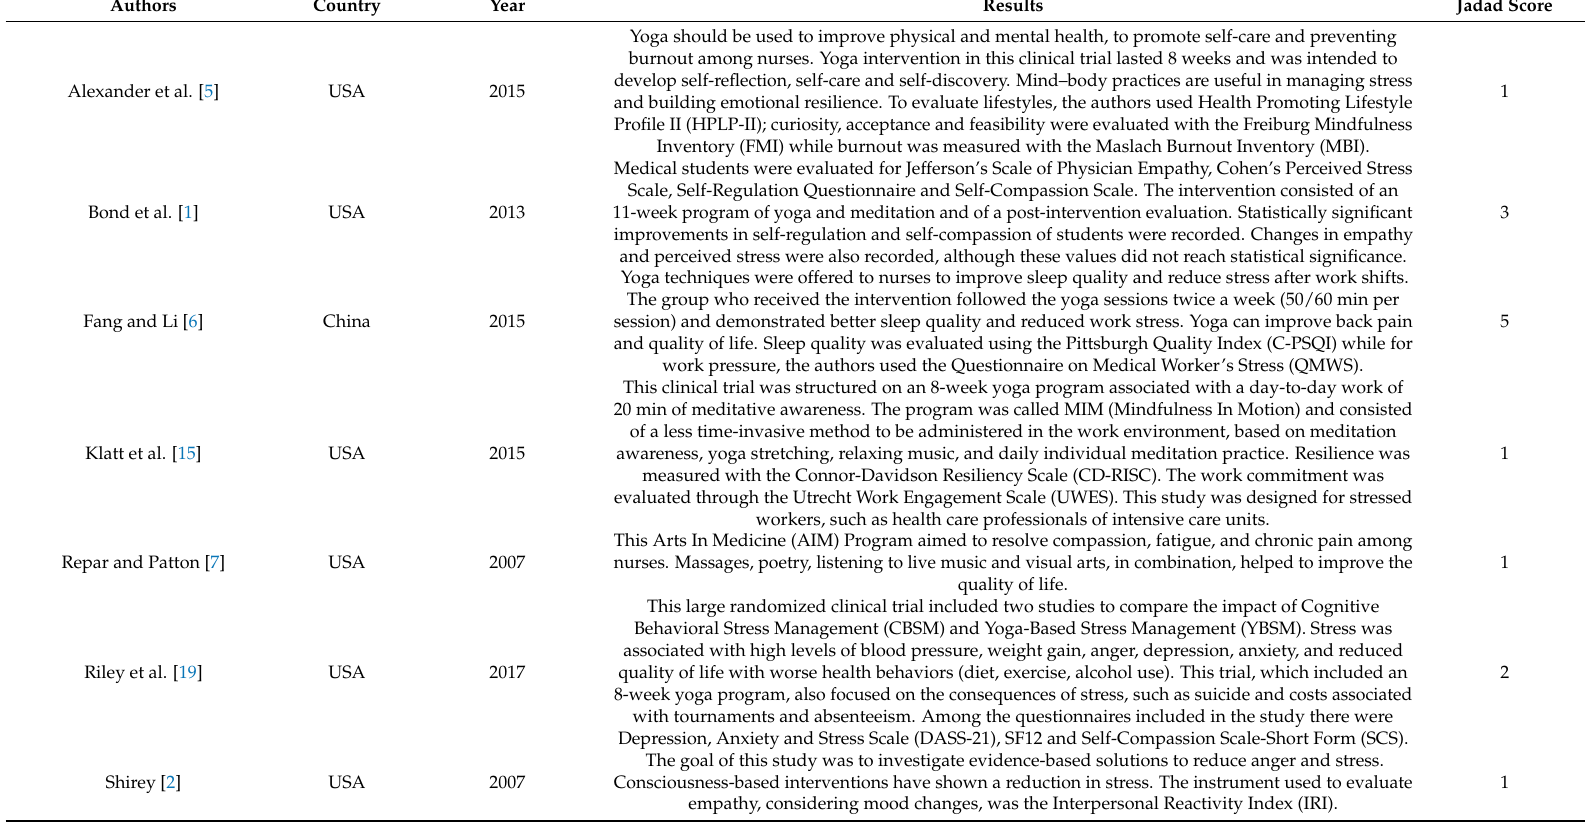
Table 1. Clinical trials included in the systematic